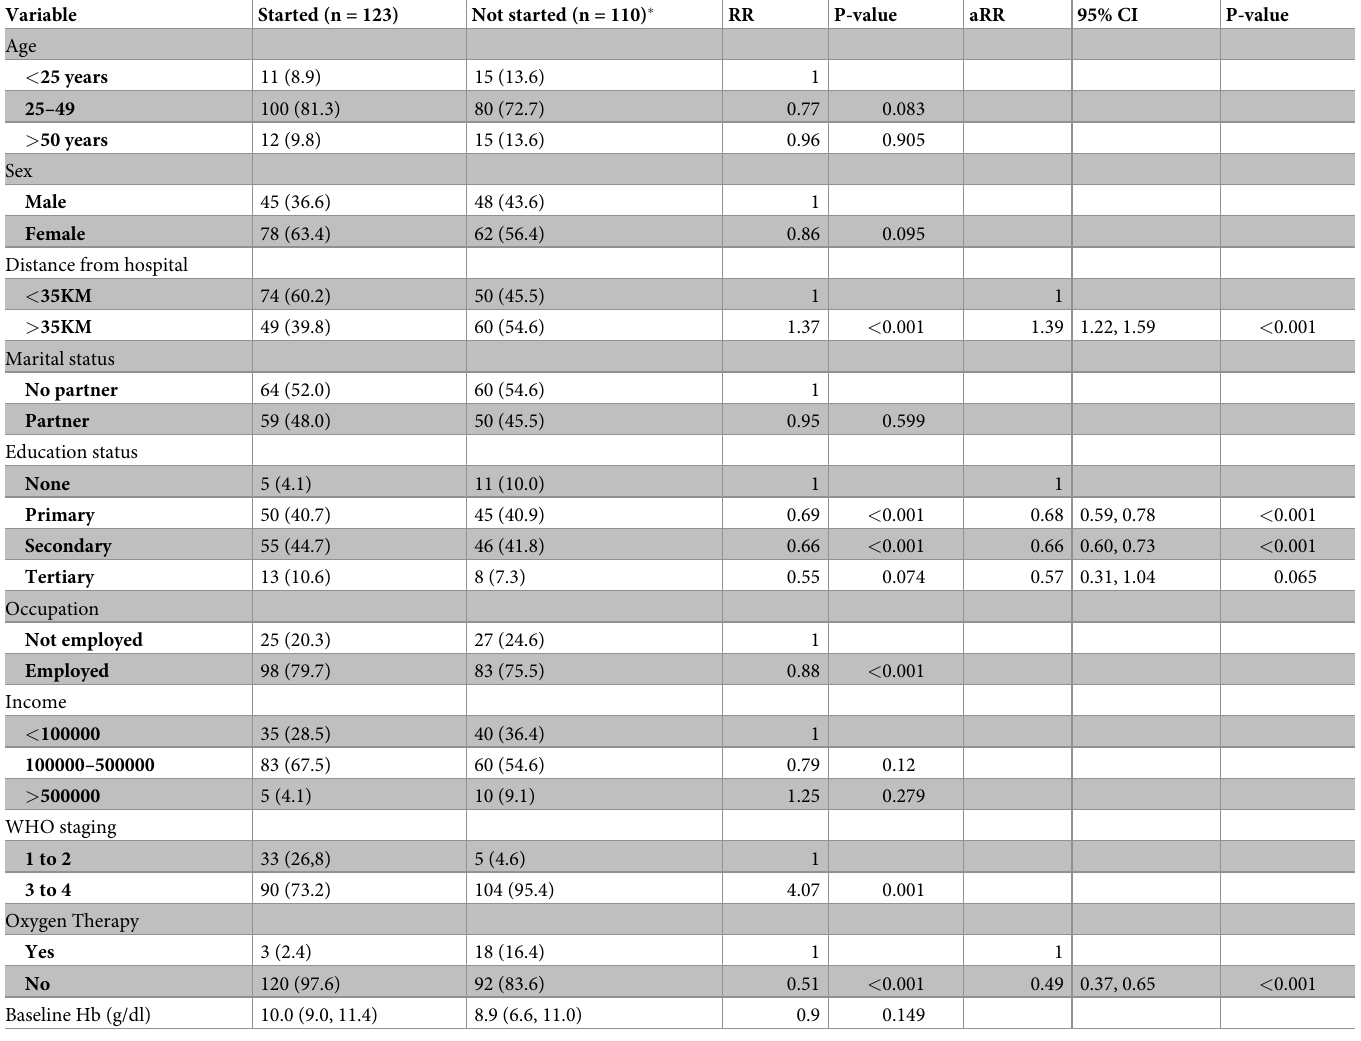
Table 4. Multivariate analysis for predictors of failure to initiate ART during